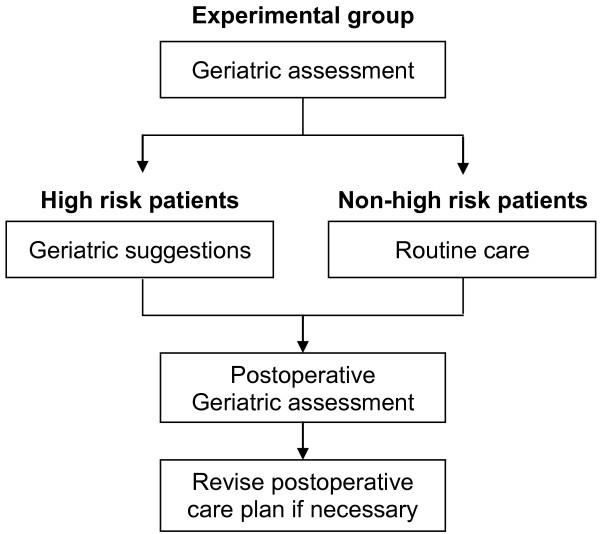
Geriatric assessment. Geriatric assessment flow chart.